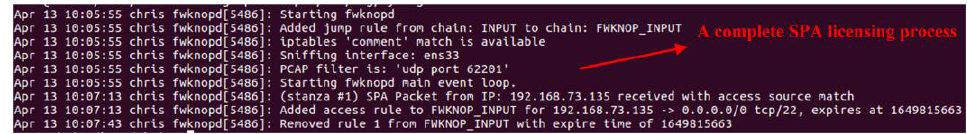
Figure 12. SPA authentication rules. 6.4.3. Request Processing and Distribution The access proxy server (192.168.73.7) contains the access information of each heter- ogeneous policy engine, configures the distribution address through the Nginx reverse proxy, configures the IP and port of the policy engine server in the upstream module and configure the main listening port and response behavior in the server module; the Nginx proxy server information in the experiment is listed in Table 4. Table 4. Policy engine information. Upstream Server